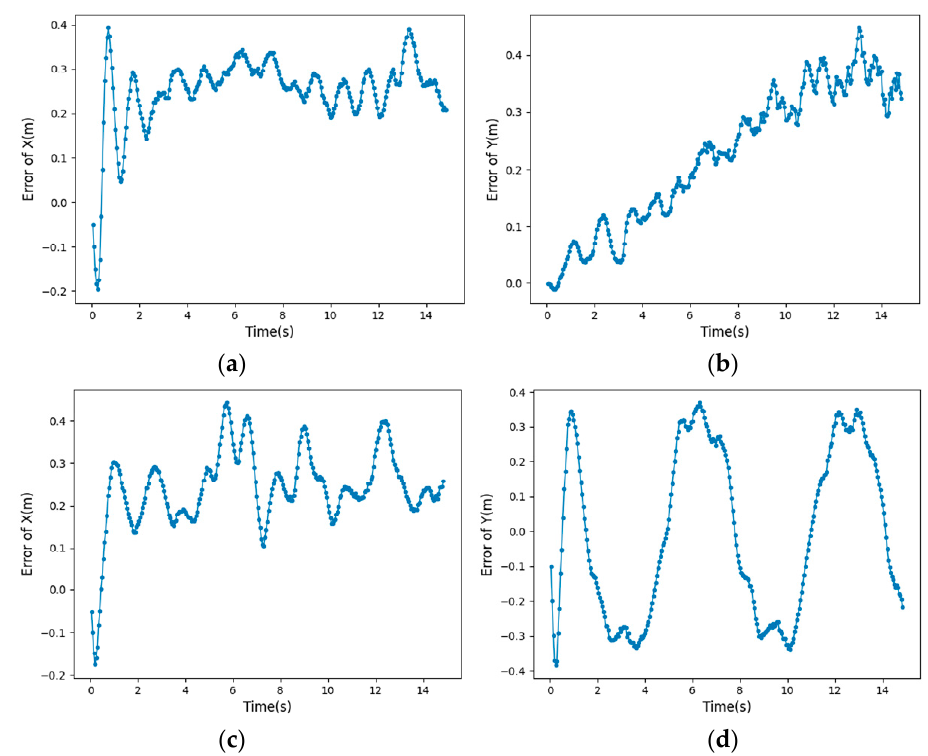
Figure 9. Trajectory tracking error distribution: ( a ) case I x-coordinate error distribution; ( b ) case I y-coordinate error distribution; ( c ) case II x-coordinate error distribution; ( d ) case II y-coordinate error distribution.